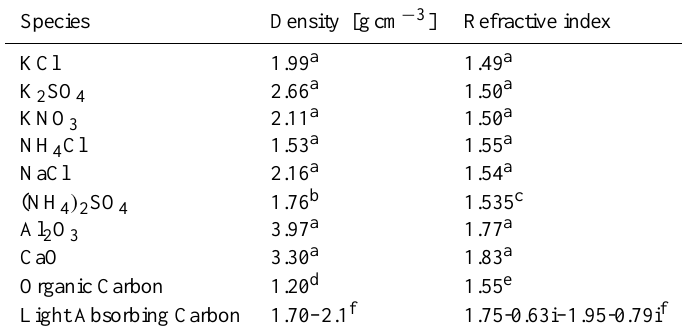
Table 3. Assumed densities and refractive indices used to calculate n comp and k comp